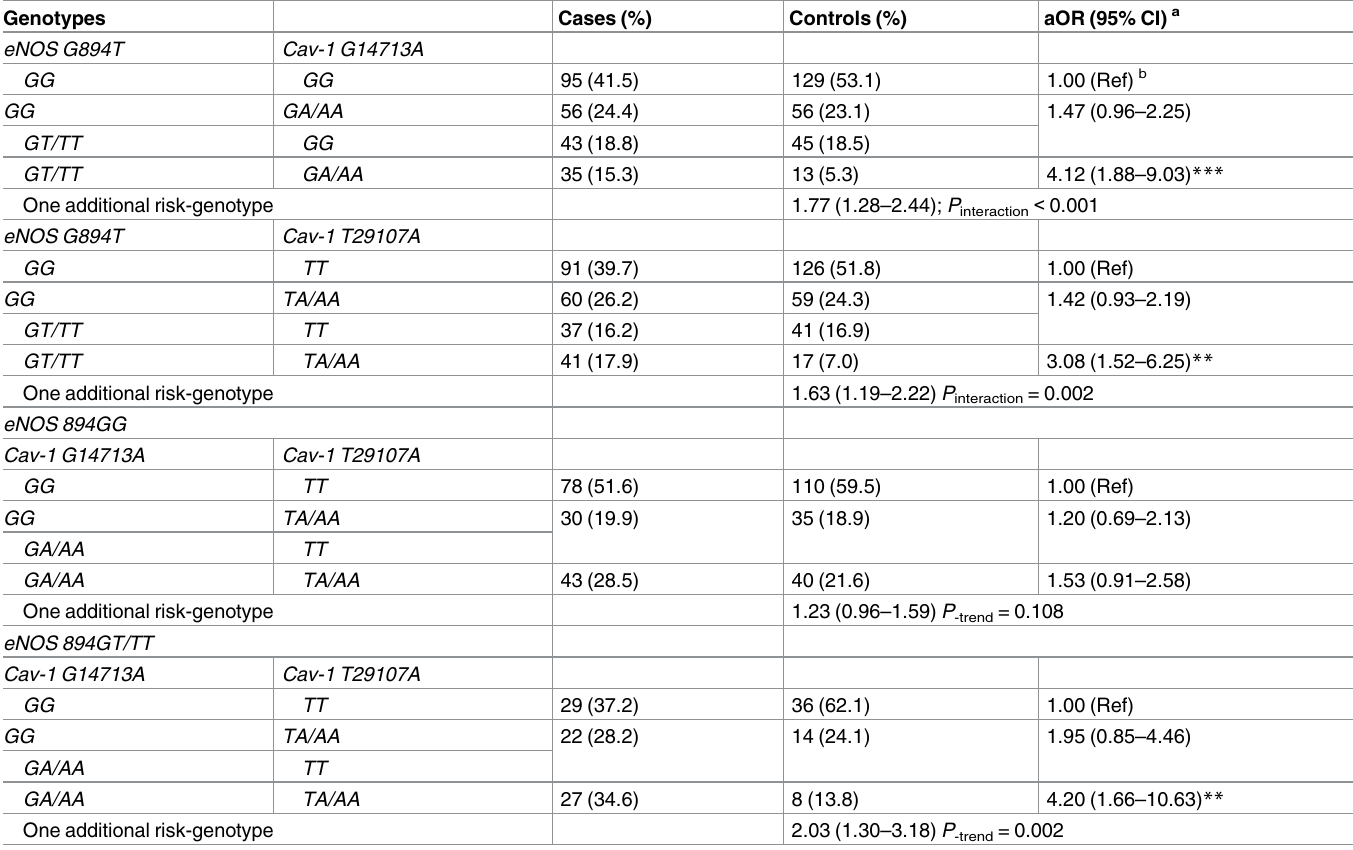
Table 4. Gene-to-gene interactions of eNOS and Cav-1 polymorphisms in association with LAA stroke.